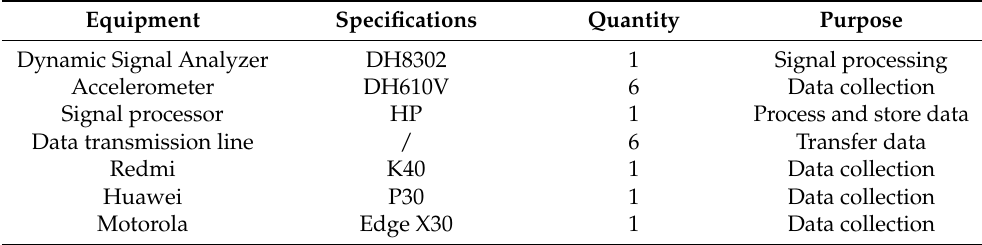
Table 2. Experimental Equipment.